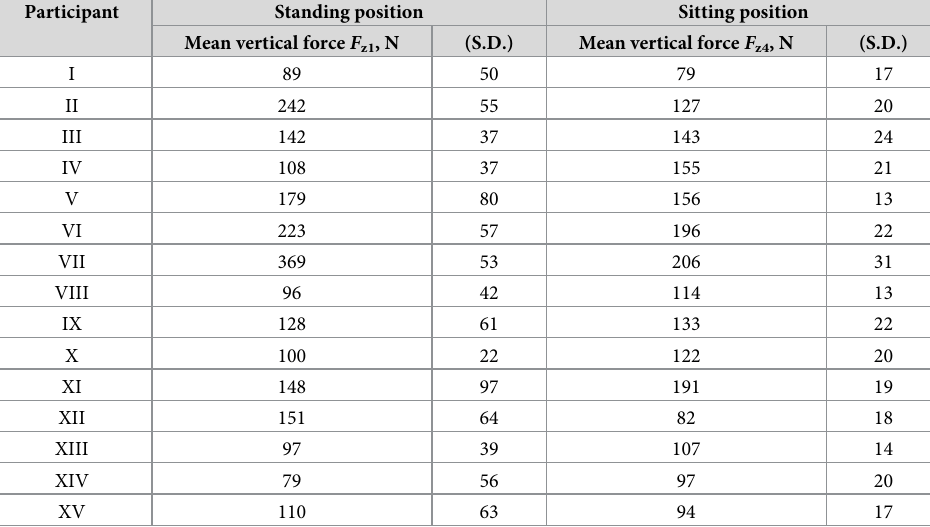
the mechanical friction test and foot rubbing test. The error bars indicate the standard devia- tion of the COF among the trials. There was almost no difference in the tendency of the order of the SCOFs between the mechanical friction test and foot rubbing in standing position. How- ever, the magnitudes of the SCOF for in standing position were greater than those for the mechanical friction test, except for sheet A. This was because the vertical forces in the standing